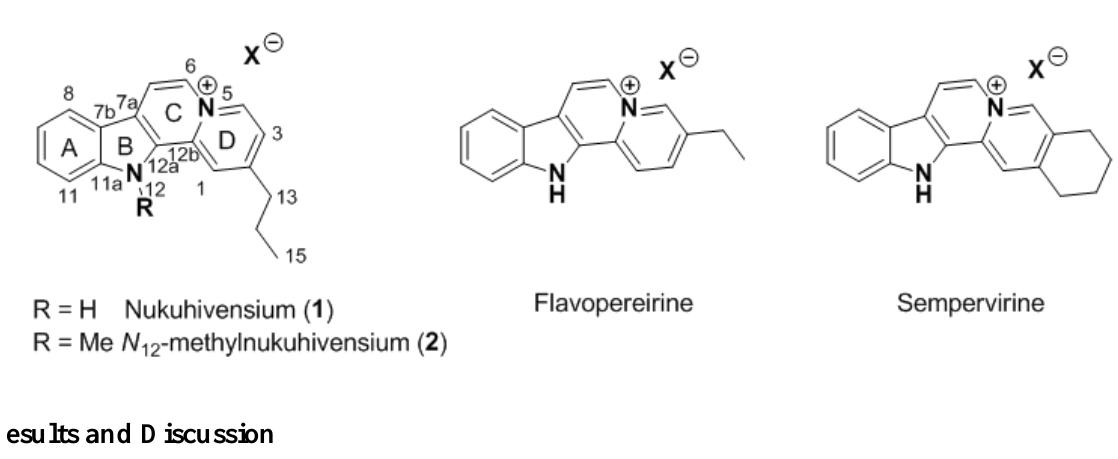
Figure 1. Structures of natural indolo[2,3- a